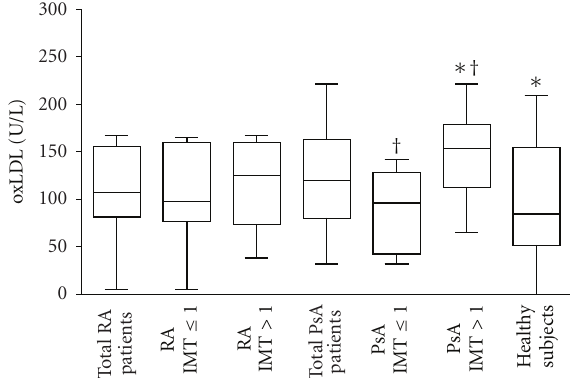
Figure 1: Oxidized low-density lipoprotein (ox-LDL) concentrations in serum samples. Box plot graphs showing ox-LDL concentrations in serum samples from the 24 patients with rheumatoid arthritis (RA) and 25 with psoriatic arthritis (PsA), divided or not according to IMT values obtained by Echo-colour Doppler images and from the 13 healthy subjects. ∗ P = 0 . 049; † P = 0 .